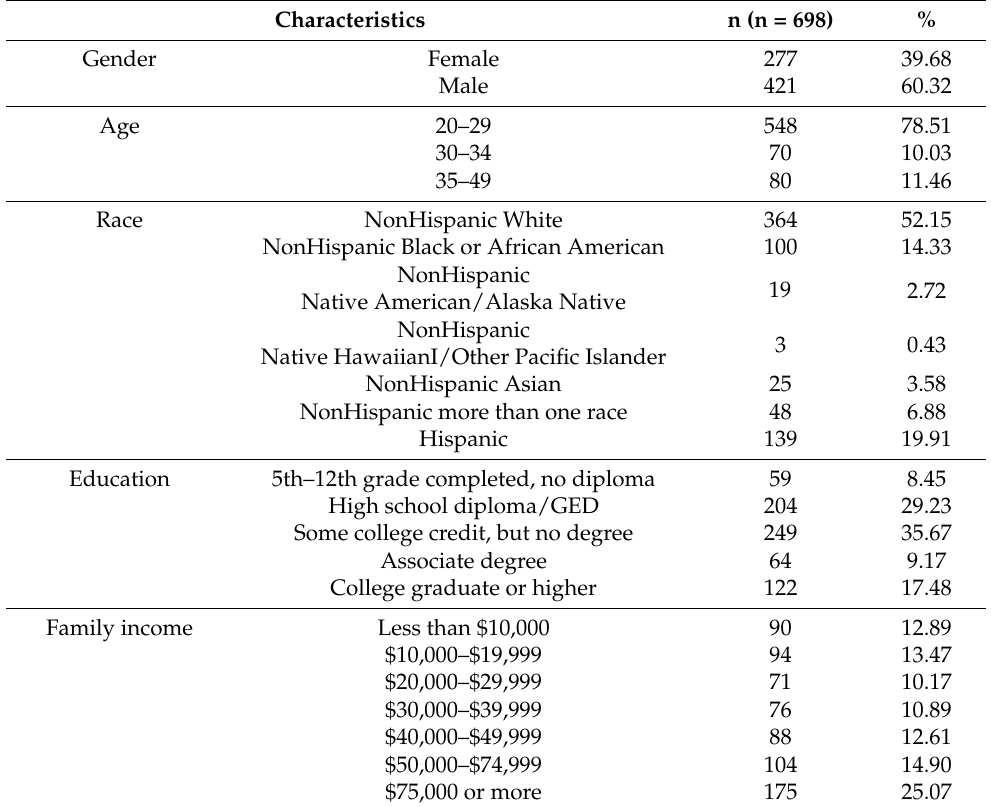
Table 1. Characteristics of participants who abuse marijuana (n =